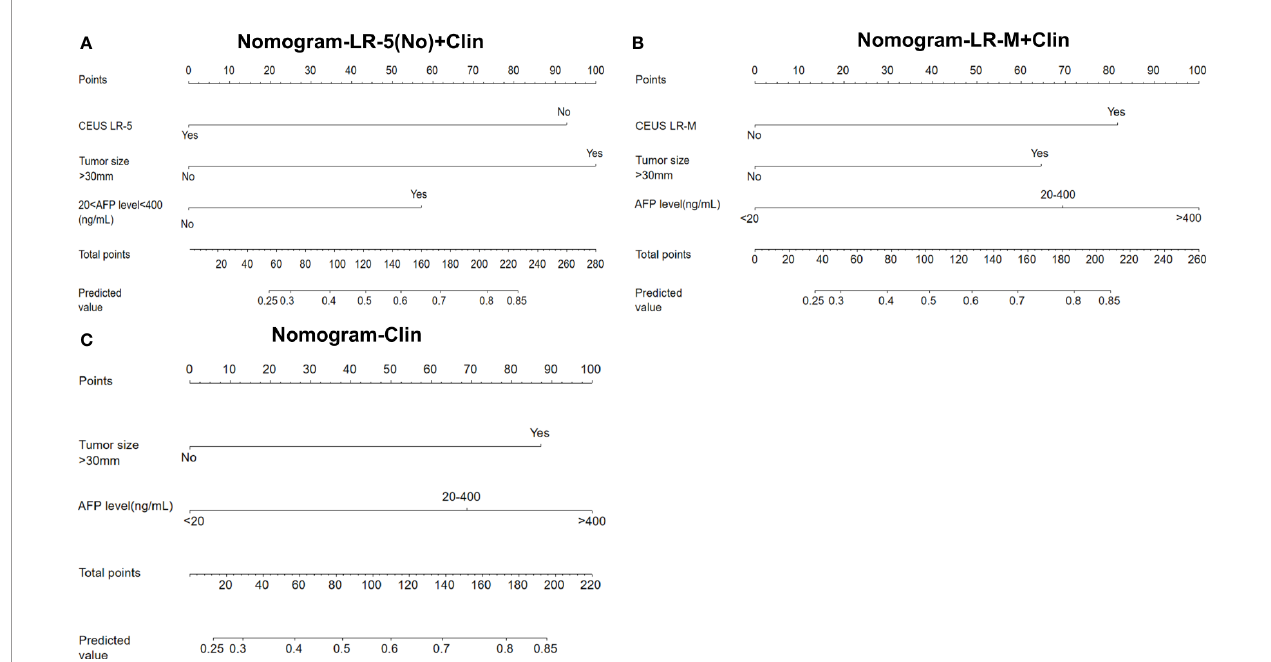
FIGURE 4 | Nomogram graphics of Clin +LR-5(No) model (A) , Clin+LR-M model (B) and Clin model (C) for predicting MVI in HCC patients. Clin, clinical information; HCC, hepatocellular carcinoma; MVI, microvascular invasion; CEUS; contrast enhanced ultrasound; AFP, alpha fetoprotein; LR-5, liver imaging reporting and data system category 5; LR-M, liver imaging reporting and data system category